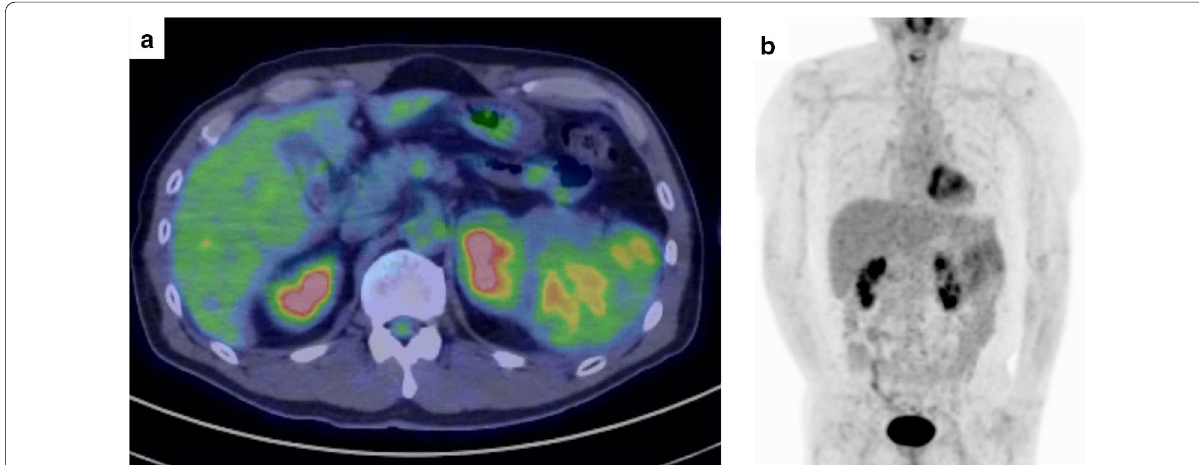
Fig. 2 a PET–CT showed an accumulation of standardized uptake value (SUV) max of 4.1. b PET–CT showed no obvious lymph node or distant